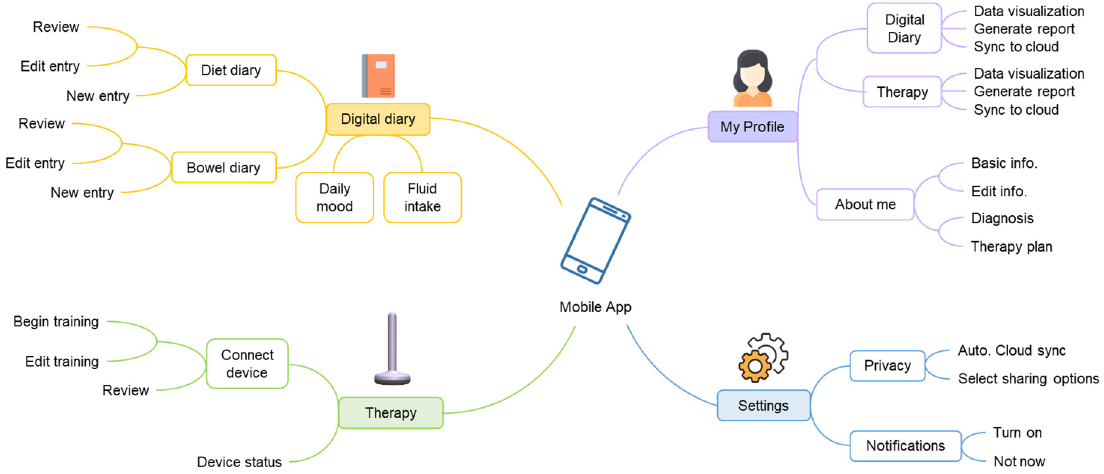
Figure 5. The information structure of the mobile app.